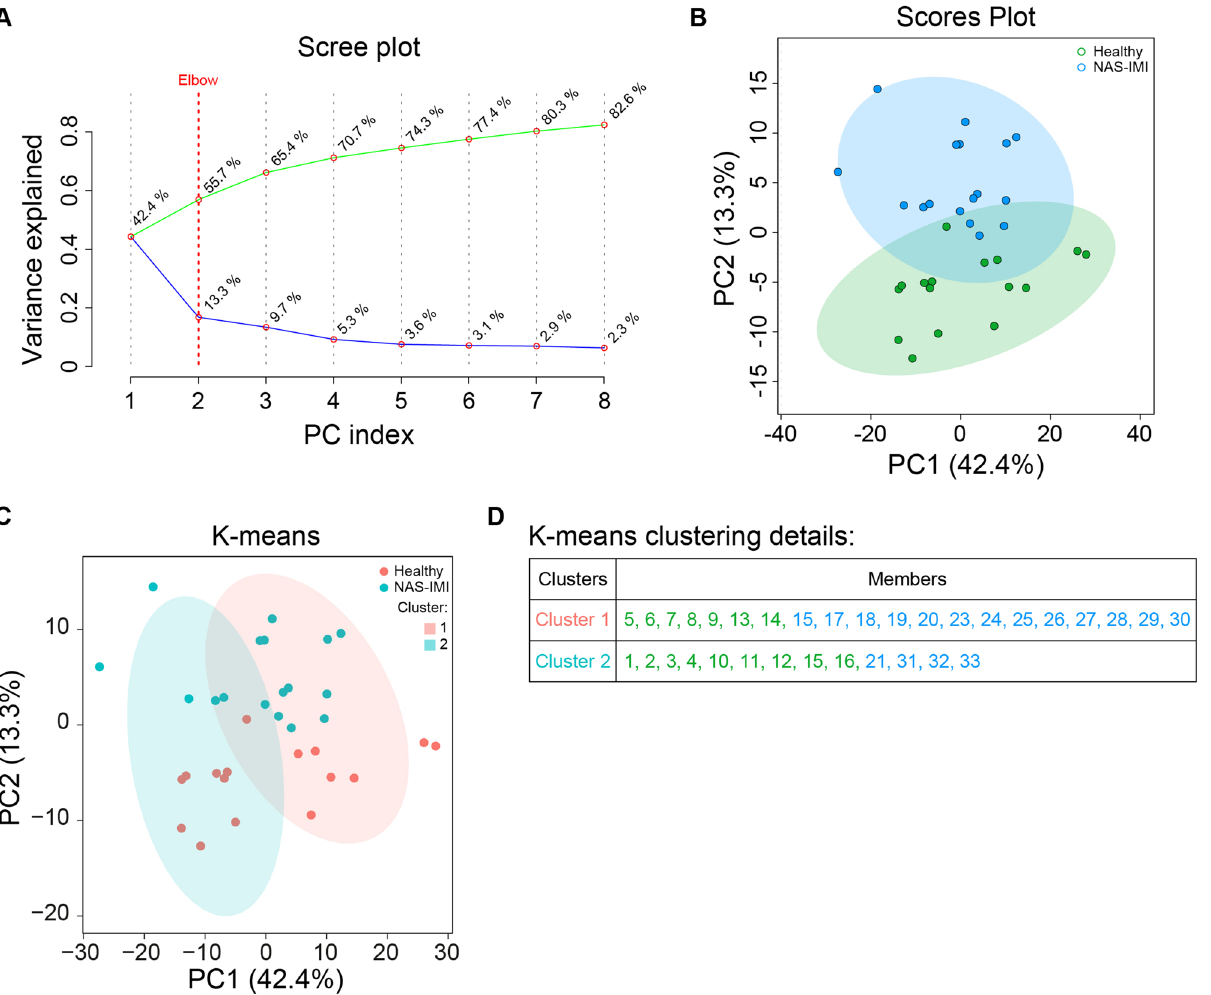
Figure 4. Lipidome discriminates between H and NAS-IMI milk. ( A ) Scree plot of the principal component analysis (PCA) representing the total variance (green line) and the single variance (blue line) explained for each component (PC index). ( B ) 2D plot of the PCA representing sample distribution based on PC1 and PC2 of lipidomic profiles of healthy (pink) and NAS-IMI (cyan) milk samples. ( C ) 2D plot of K-means clustering based on PC1 and PC1 from PCA. ( D ) Details of samples distribution among K-means